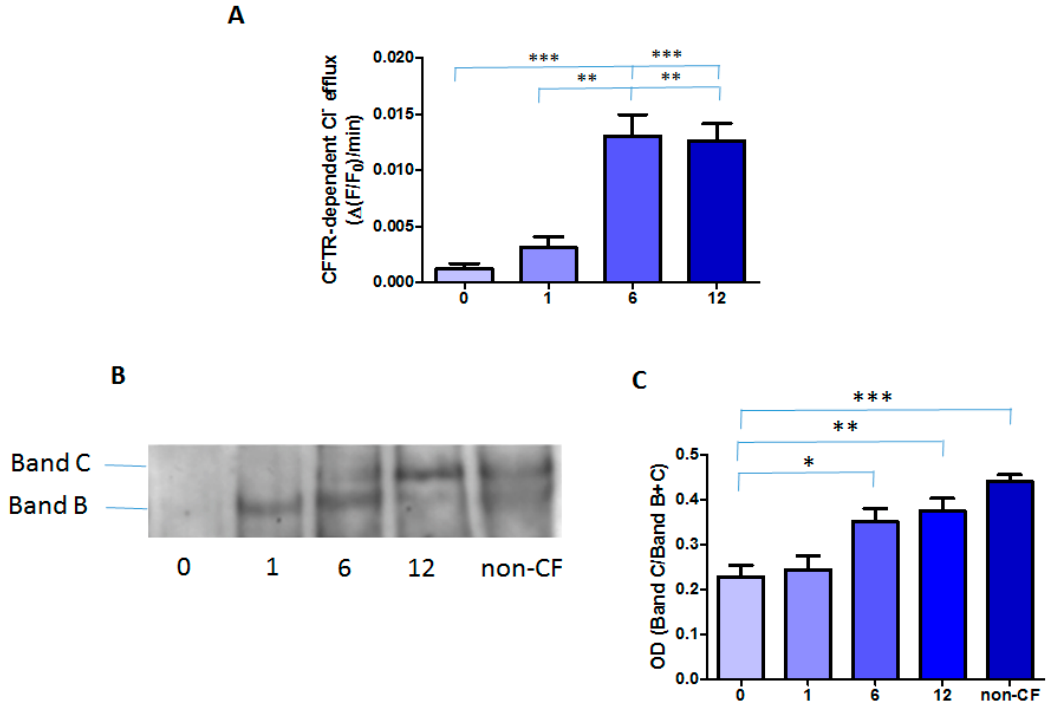
Figure 3. CFTR activity and protein in MNCs: ( A ) cumulative data of CFTR activity obtained from 14 patients; ( B) a representative Western blot of CFTR protein; and ( C ) densitometric analysis of Western blots represented as the OD ratio of Band C over Bands B and C in three CF subjects and in a pool derived from five non-CF subjects. Data are shown as mean ± SEM. * p < 0.05, ** p < 0.01, *** p < 0.001.